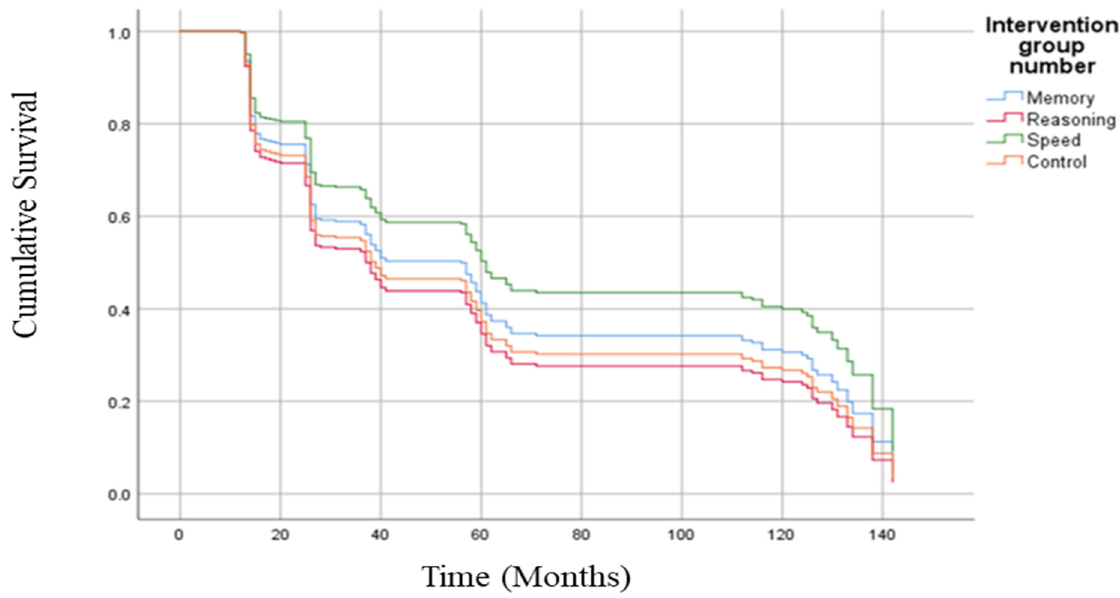
Figure 3. Survival curves of high-risk sample. There were significant differences between the speed of processing and no-contact control group (HR = 0.69, p = 0.049) but not the memory or reasoning training groups among the high-risk sample ( p > 0.05).